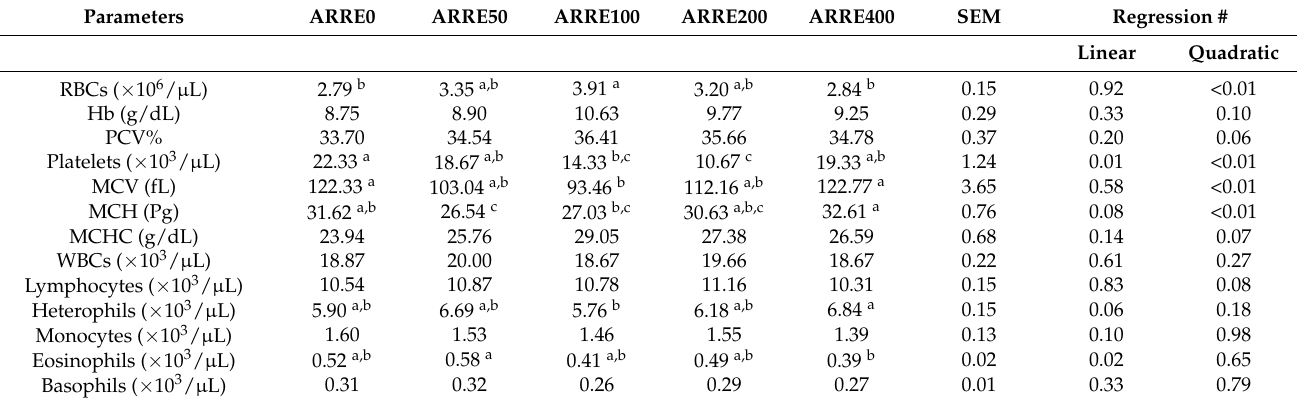
Table 6. The effect of dietary supplementation of ARRE on the blood hematology of broiler chickens.